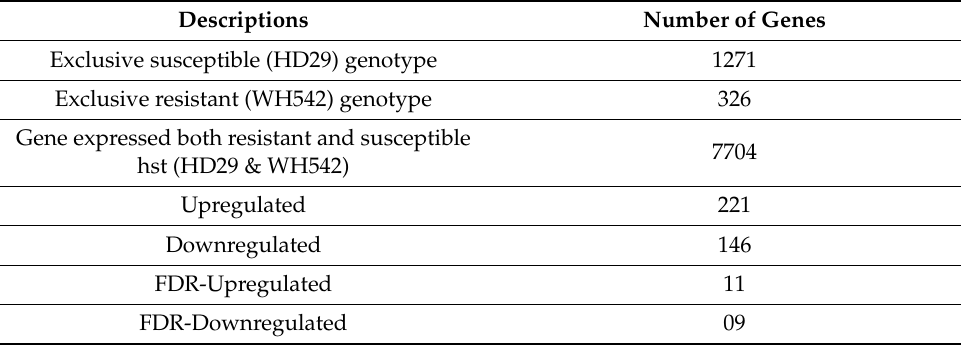
Table 4. DESeq analysis of T. indica up on